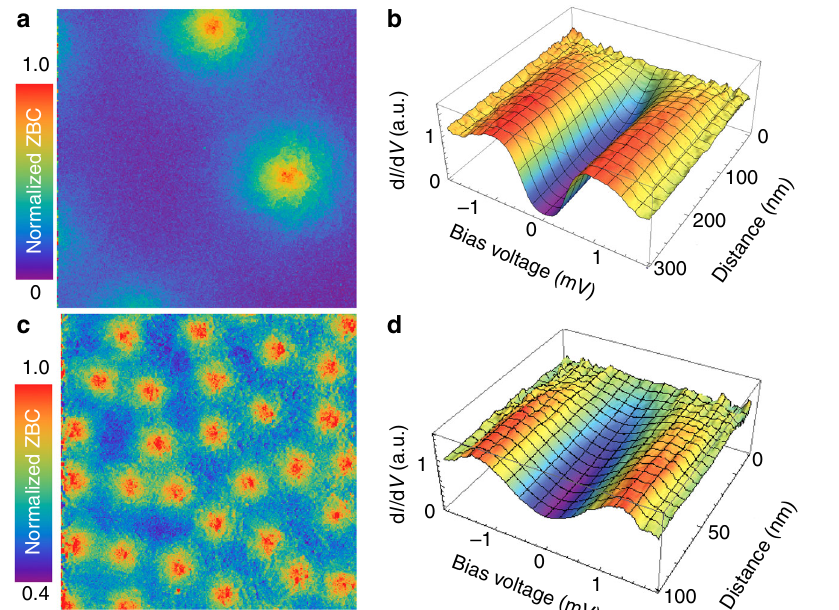
Fig. 2 Overlap of proximity vortex cores. a , c 800 nm × 800 nm ZBC maps acquired at 300 mK in magnetic fi elds of 5 and 55 mT, respectively. b , d Radial evolution of the tunneling conductance spectra in the vicinity of the proximity vortex cores. The applied magnetic fi elds are the same as in a , c . Due to their ’ 4 T large cores, the proximity vortices strongly overlap already at low fi elds, H (cid:5) H Nb c2 | DOI: 10.1038/s41467-018-04582-1 |